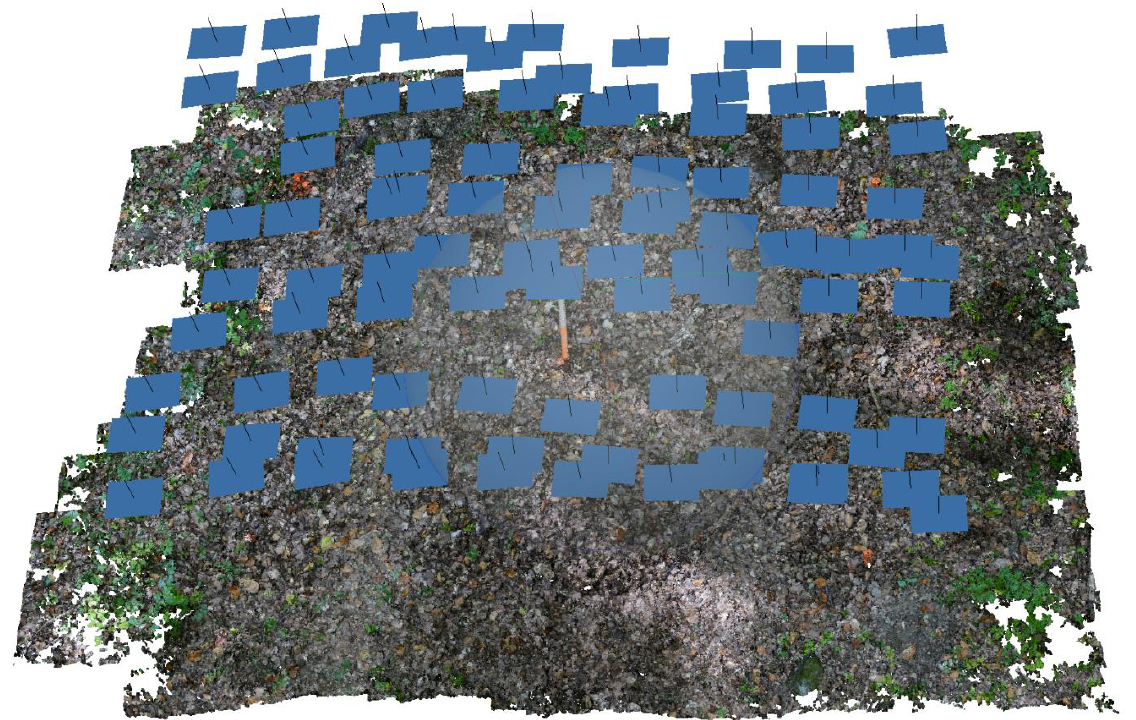
Figure 2. Placement pattern of the camera during photographic scanning of a single plot.